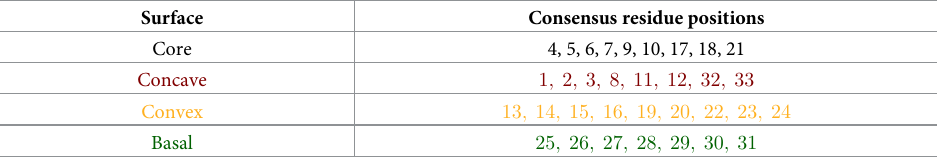
Table 1. Classification of the 33 positions within the ANK in the different